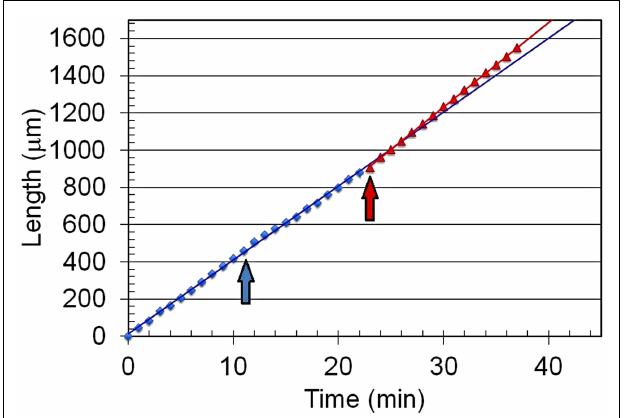
FIGURE 4 | Elongation as a function of time for an in vivo creep experiment. The length is plotted against time for a stiff mutant stage IVb sporangiophore (C216).The first vertical arrow (blue) indicates the time when the stalk of the sporangiophore was impaled to measure the turgor pressure.The second arrow (red) indicates the time when the step-up in turgor pressure was produced with the pressure probe by continually injecting oil into the vacuole to maintain the higher pressure.The data points before (blue) and after (red) the turgor pressure step-up are each fit with a straight line. It can be seen that the slope of the red line (after the turgor pressure step-up) is larger than that of the blue line (before the turgor pressure